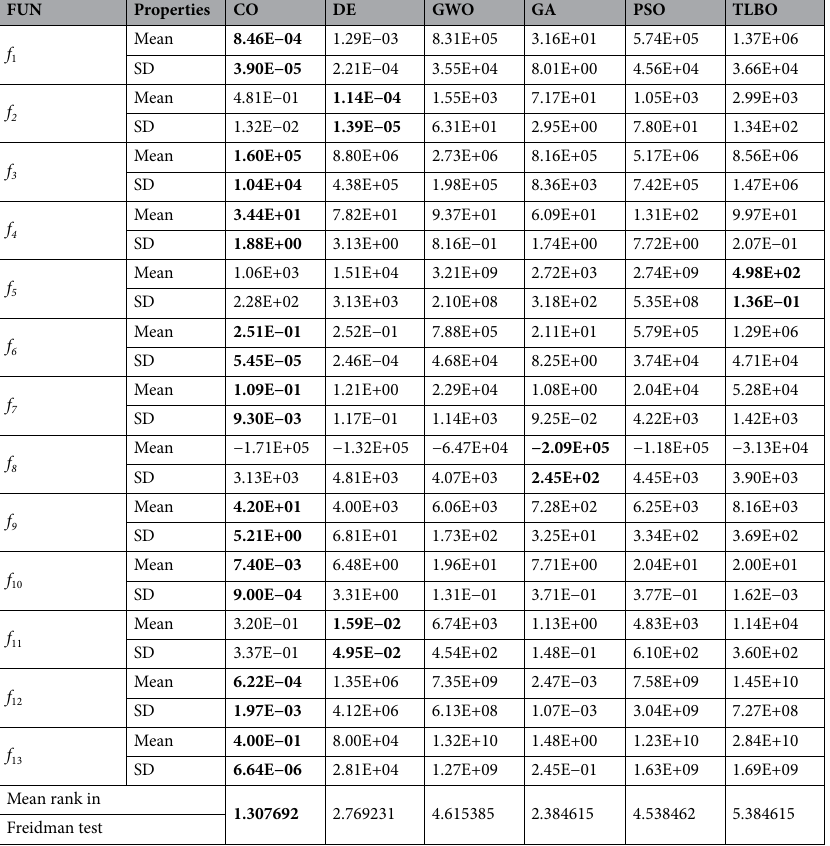
Table 3. Results of 500-D shifted CEC2005 test functions. Significant values are in [bold].